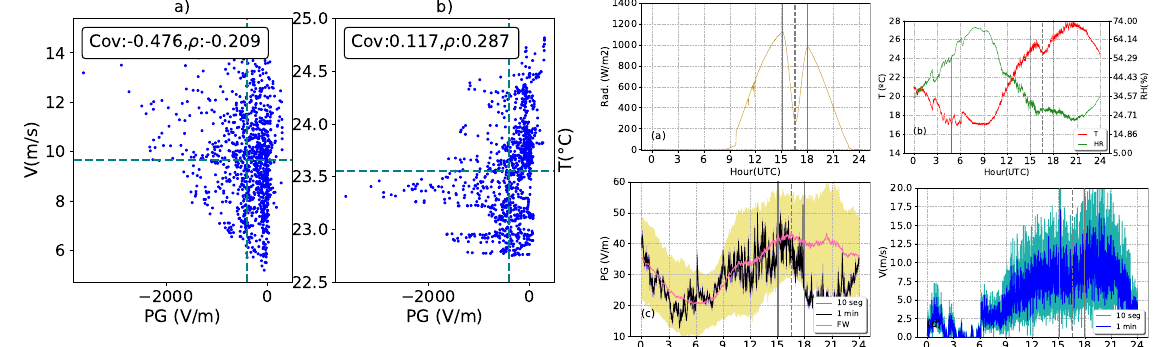
Figure 4: Scatter plots in Valcheta during the time of the eclipse: (a) PG versus wind intensity (every 1 minute), (b) PG versus temperature (every 1 minute). At the top left corner of each panel, the covariance (cov) and correlation coefficient ( rho ) values are presented for each set. The vertical dotted lines correspond to the mean values of the series under analysis.